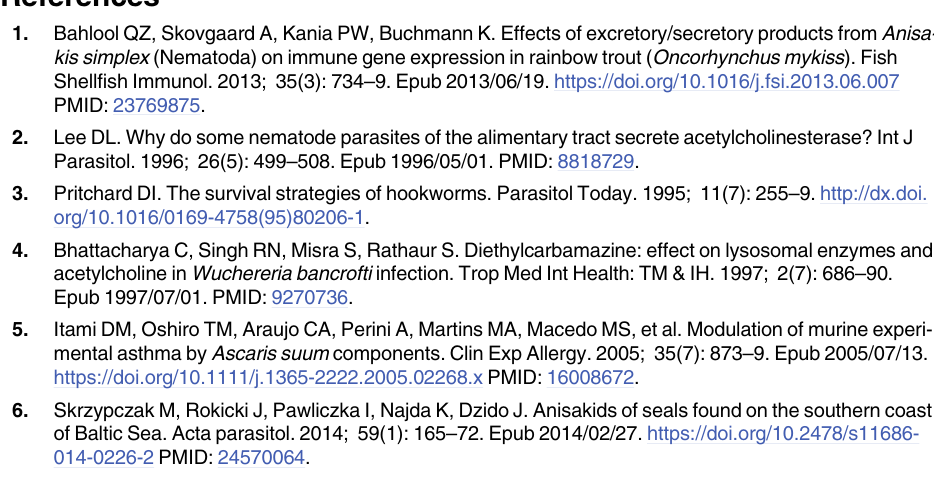
S1 Table. Primers and probes used for immune genes expressed in zebrafish. (DOCX) S2 Table. Genes expressed at low levels. A few genes were expressed at low levels, especially in the non- stimulated group ( C ). This will exclude using the - ΔΔ Cq method for assessing the fold regulation quantitatively. Thus, these genes were assessed qualitatively (regulation or not) rather than assessed quantitatively by recording the presence of valid Cq values ( a ) [23]. The non-parametric Mann-Whitney’s U-test ( b ) was used to test for differences between the stimu- lated groups against the non- stimulated group. From each group 10 fish were